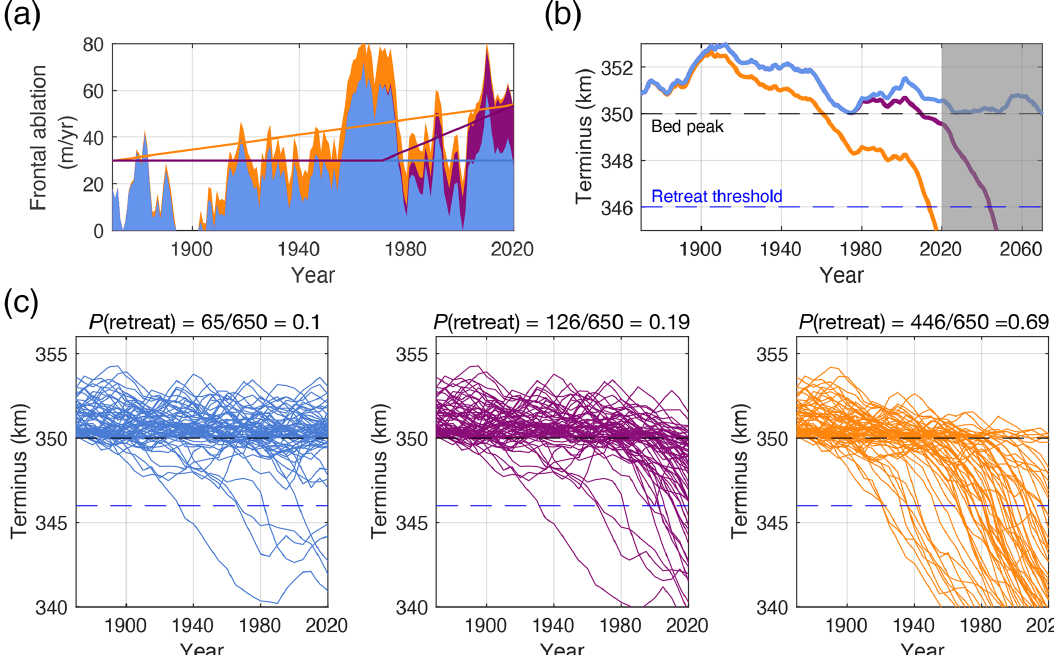
Figure 5. The effect of a persistent trend on retreat probability. (a) Three forcing scenarios: no trend (blue), an 80% increase in frontal melt over 150 years (orange), and a delayed trend of the same total magnitude but over 50 years (purple). Solid lines show the forced trends in frontal ablation, while shaded regions illustrate one realization of stochastic variability added to each scenario. (b) Glacier-terminus responses to the forcing shown in (a) . The plot extends past the 150-year experimental interval to show the long-term glacier response to prior forcing (grey shaded); no additional trend is applied after 150 years. (c) Ensemble results (i.e., independent realizations of variability) for these three trend scenarios. For clarity, only 10% of ensemble members are